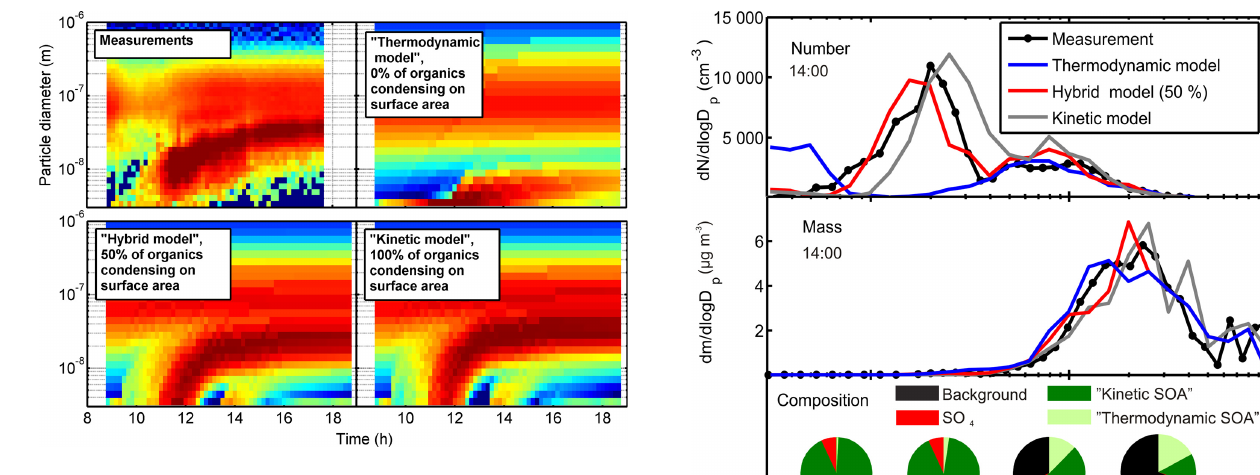
Fig. 5. A comparison between the evolution of the atmospheric size distribution on 15 April 2007 in Hyyti¨al¨a (top left) with the box model calculations assuming 0% (top right); 50% (bottom left); 100% (bottom right) of the organic mass to condense on the aerosol surface area. In the top right panel only sulfuric acid is condensing on the surface area of the aerosol – the organics are distributed to the pre-existing mass.